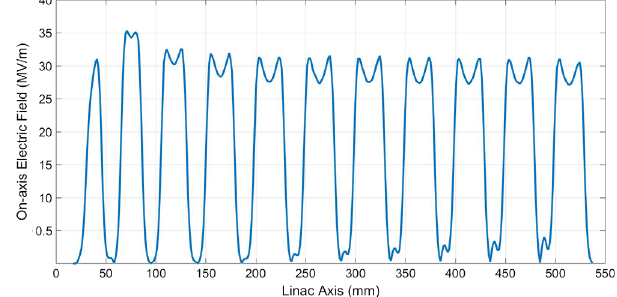
FIG. 5. On-axis accelerating electric field.